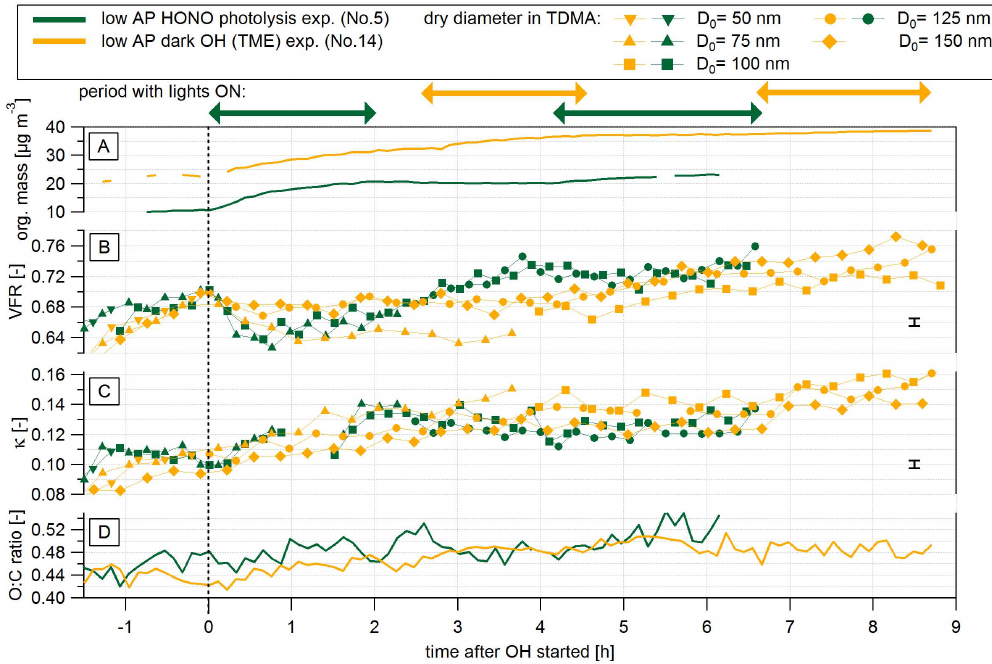
Fig. 9. Results from low concentration α -pinene experiments No. 5 (OH from HONO photolysis, green) and 14 (OH from TME, yellow) are plotted as time series of: (a) wall-loss corrected organic aerosol mass (org. mass), (b) volatility as VFR at 70 ◦ C, (c) hygroscopicity parameter κ , and (d) O:C ratio. The lights were intermittently turned on and off during these two experiments. The double arrows above the figure indicate the periods with lights on. The symbols and colors in panel (b) and (c) indicate the dry diameter ( D 0 ) for the TDMA measurement and show the size dependence of volatility and hygroscopicity. Exemplary error bars at the right end of each panel represent the reproducibility of the